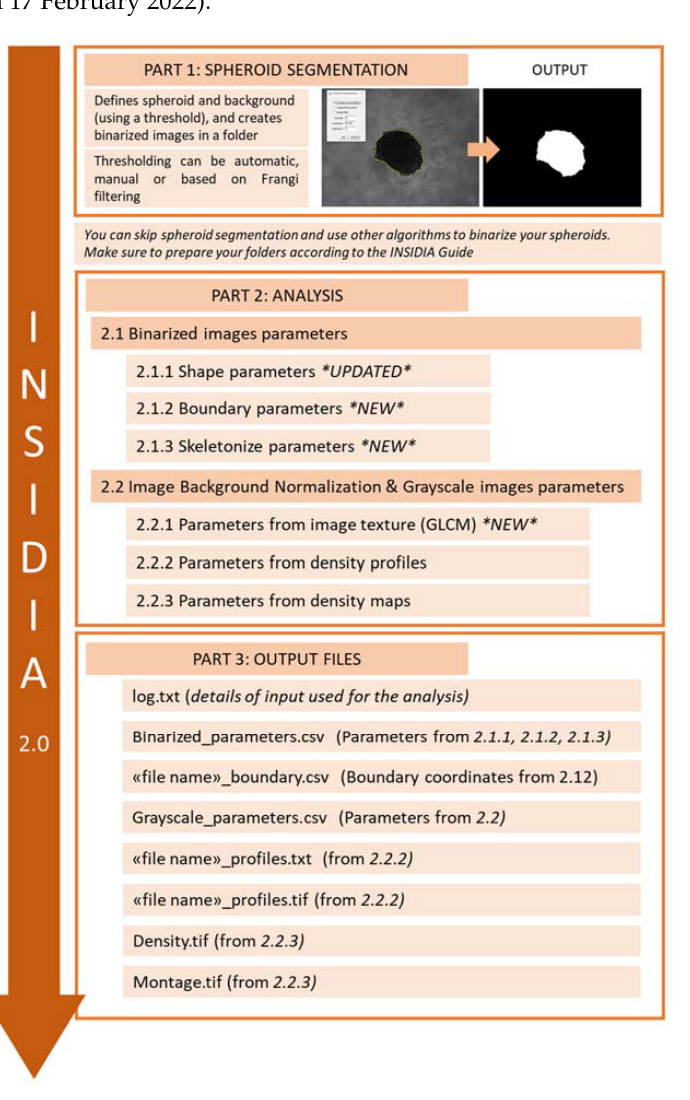
Figure 1. INSIDIA 2.0 workflow comprises spheroid segmentation (optional), analysis of binarized and grayscale images, and generation of output files.